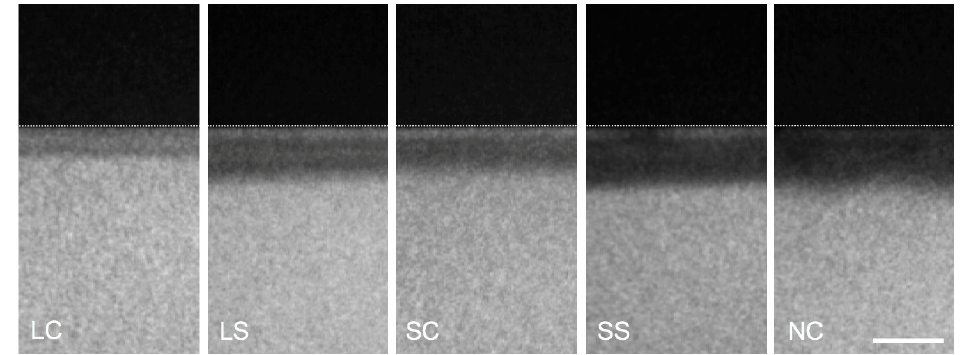
Figure 4. Representative microradiographs of the carious lesions on enamel surface induced by the multispecies biofilms after 10 days. The dotted white line indicates the lesion interface. The mean value of lesion depths differed from 78.2 μ m (LC) to 122.4 μ m (NC). LC: L. reuteri whole culture; LS: